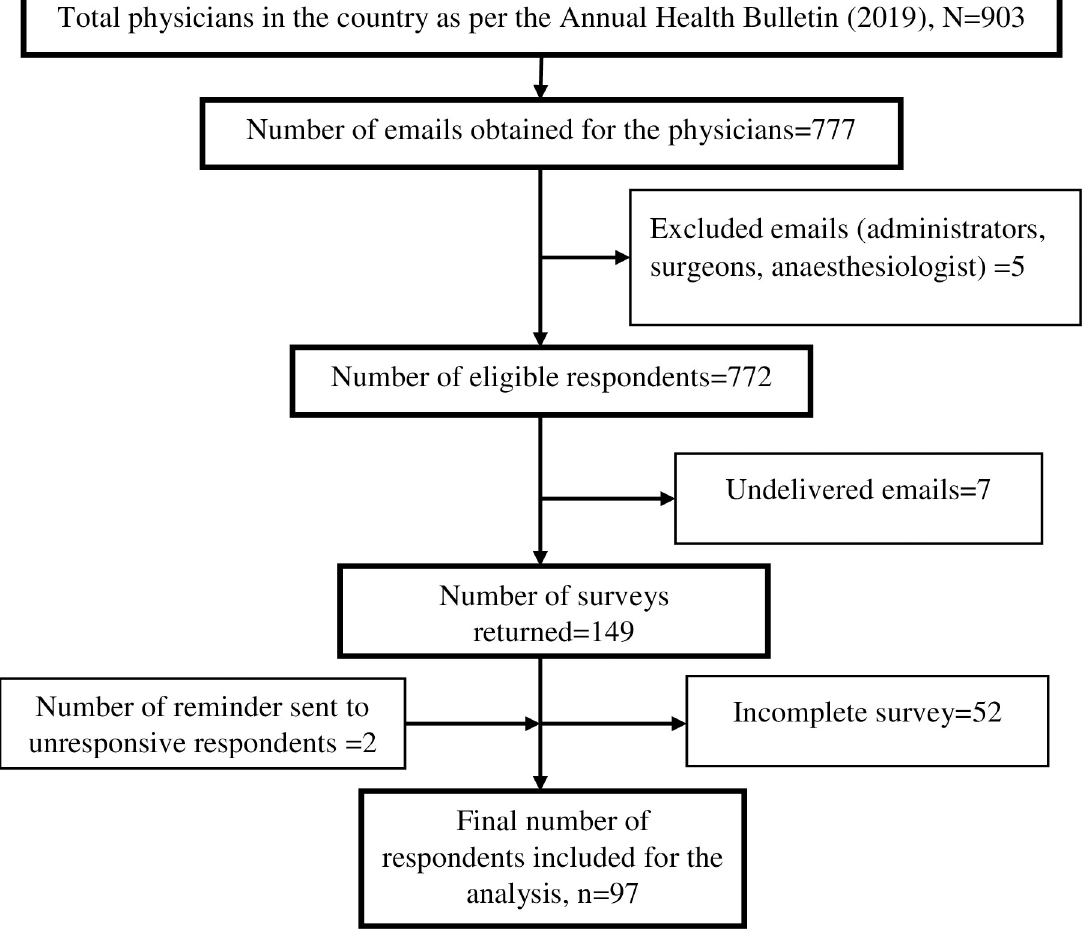
Fig 2. Study population recruitment for assessing knowledge on dengue management among physicians in Bhutan, 2019–2020.